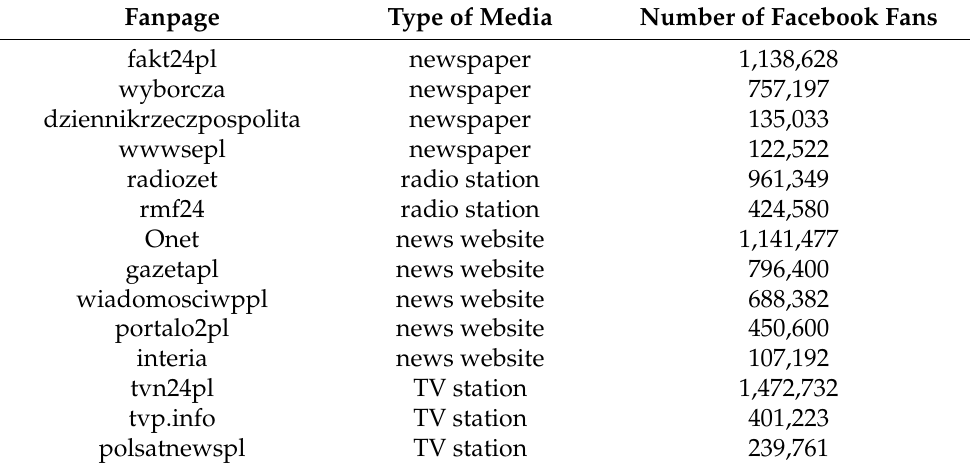
Table 1. Media included in the study.